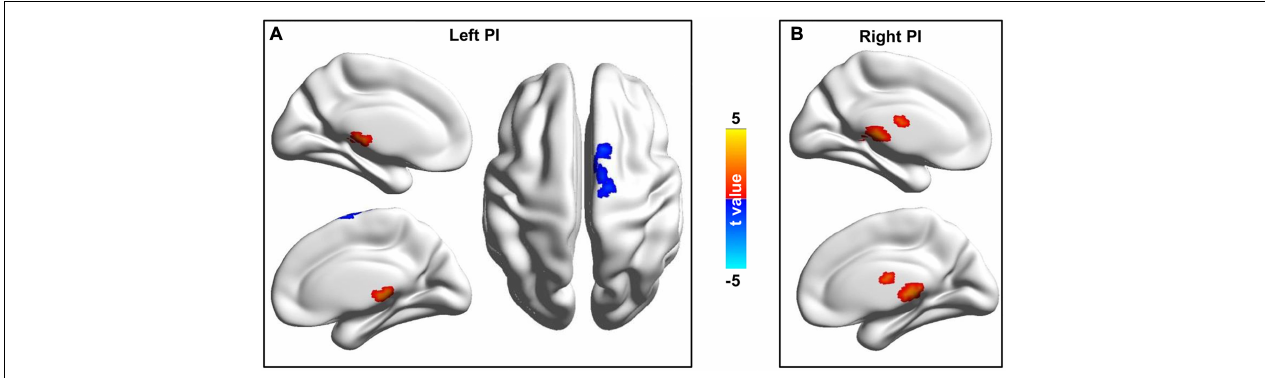
FIGURE 2 | Changed resting-state functional connectivities of the bilateral posterior insula (PI) in CDP patients. (A) Left PI showed increased functional connectivities with the thalamus and decreased functional connectivities with the middle cingulate cortex/supplementary motor area in CDP patients compared to healthy controls. (B) Right PI showed increased functional connectivities with thalamus in CDP patients compared to healthy controls.